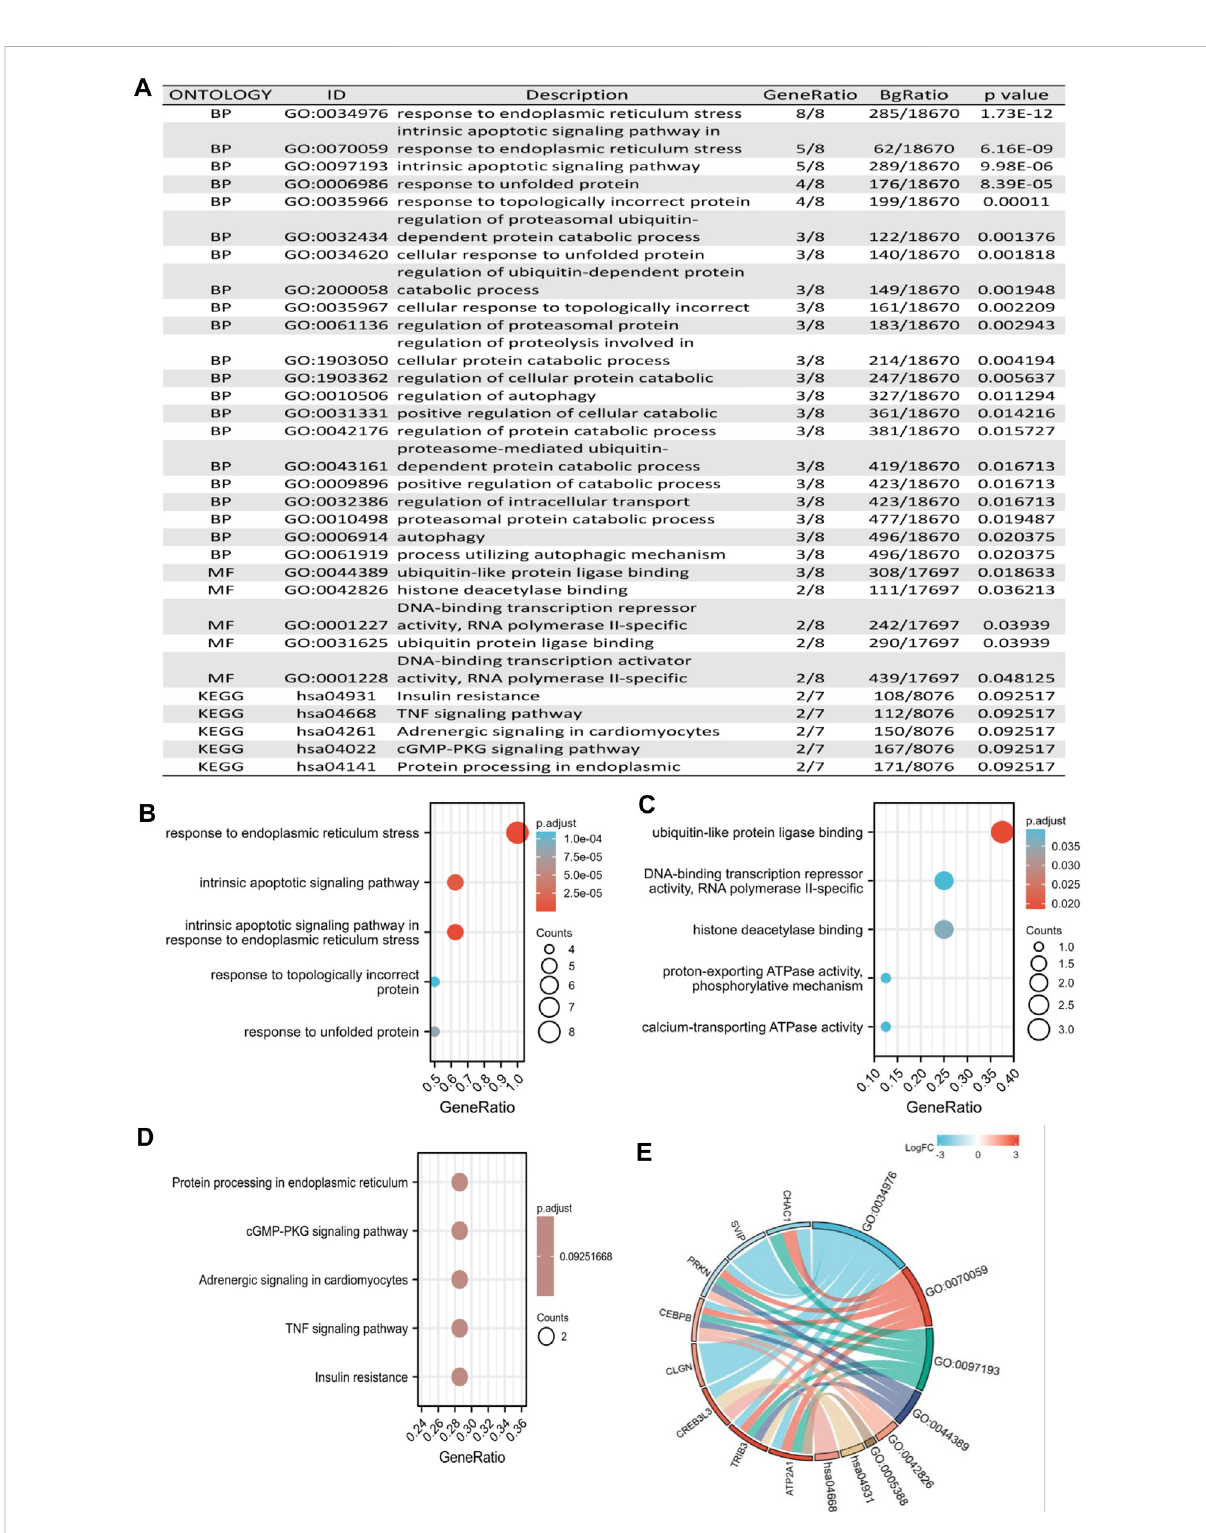
FIGURE 9 Functional analysis of DEGs based on the prognostic model. (A) Potential biological functions between the two risk groups in KIRC. (B,C) GO enrichment analysis of DEGs based on a prognostic model, including biological processes and molecular function. (D) KEGG pathway enrichment analysis of DEGs based on the prognostic model. (E) Chord diagram visualized the correlation between eight ER stress-related DEGs and potential biological functions.